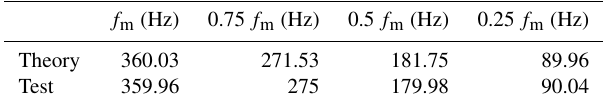
Table 4. Frequency multiplication response of the gearbox at n = 1500rpm.